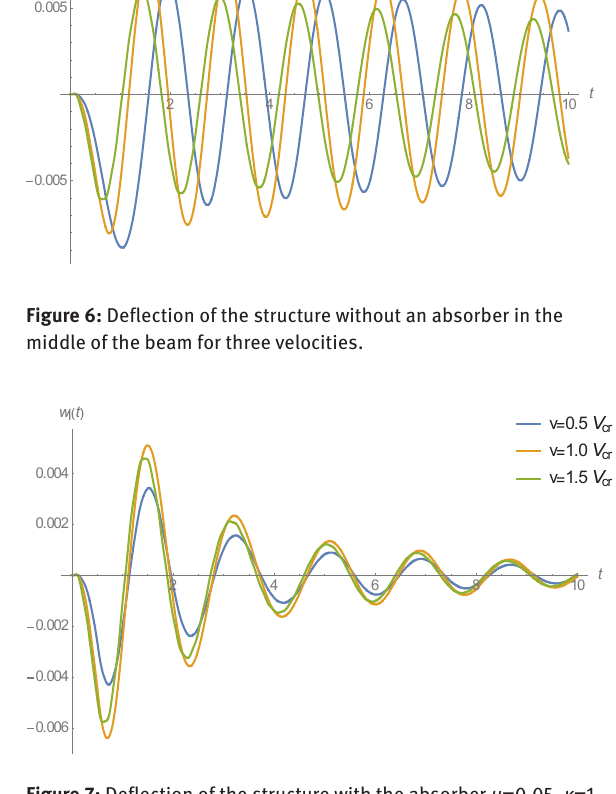
Figure 7: Deflection of the structure with the absorber μ =0.05, κ =1 in the middle of the beam for three